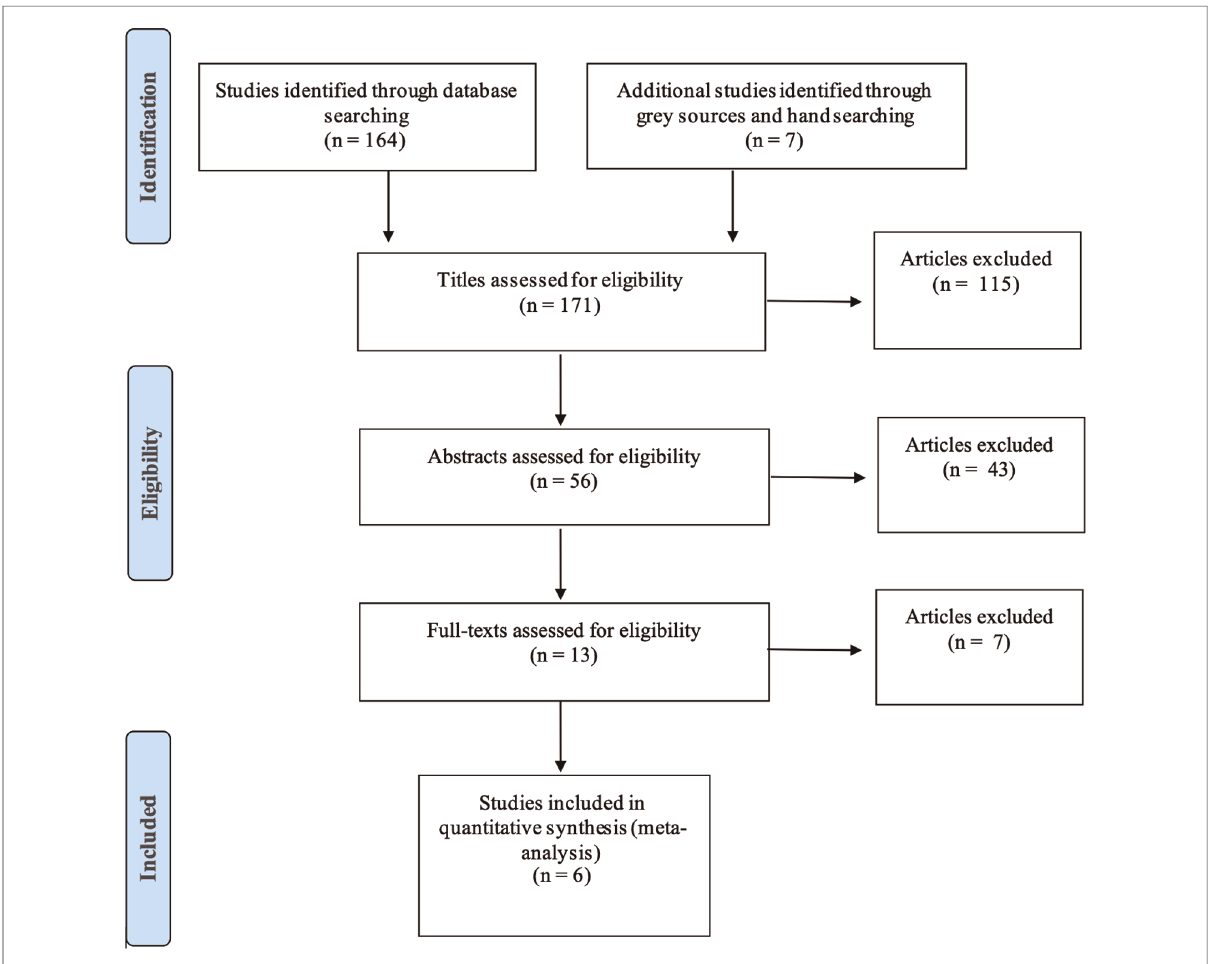
FIGURE 1 PRISMA fl ow